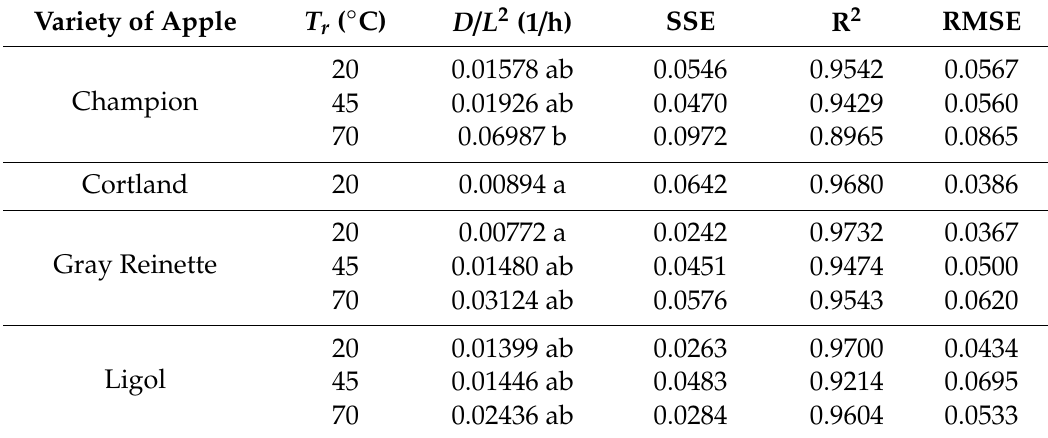
Table 7. Results of statistical analyses on the rehydration modeling of di ff erent varieties of dried apples using Fisk’s second law model (Equation